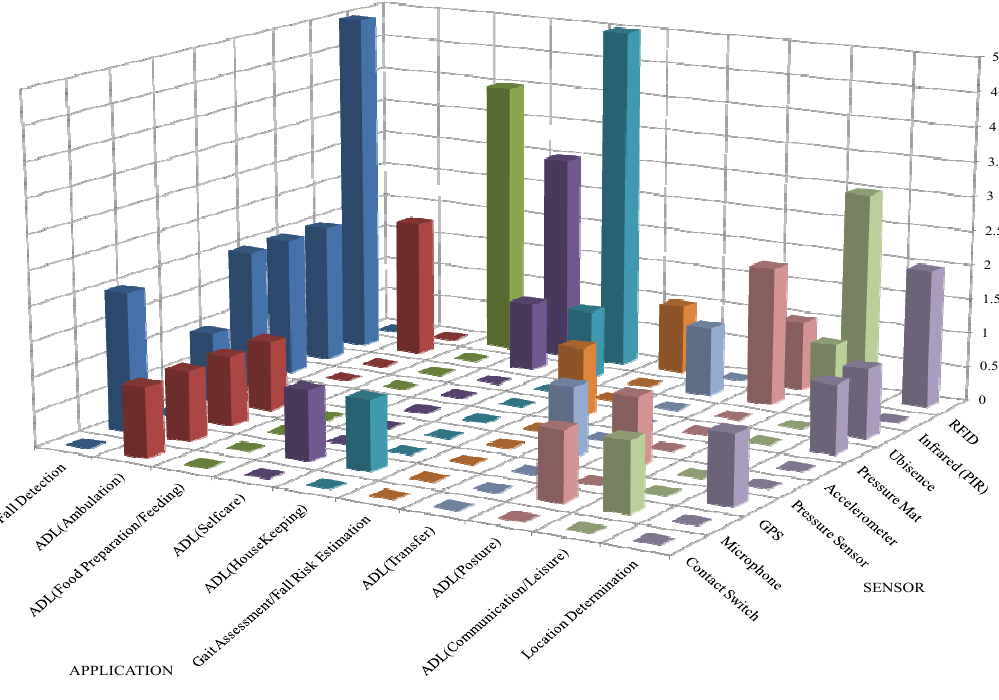
Figure 3. Distribution of research studies based on fixed